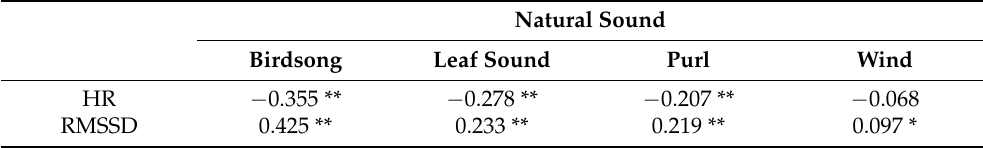
Table 6. Pearson correlation between natural park sounds and heart rate variability.